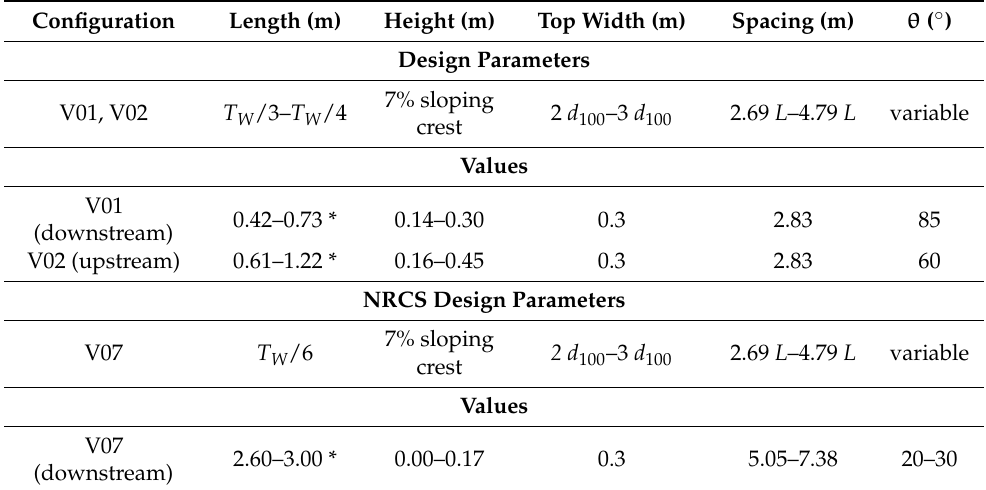
Figure 4. Native topography plan view schematic and constructed modeled surface [21]. Table 2. Model Rock Vane Configurations